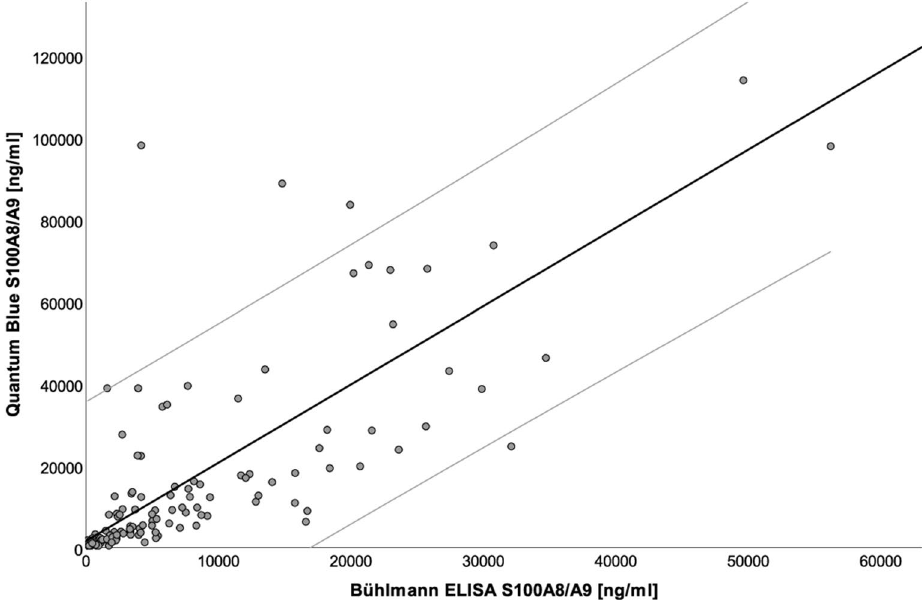
Figure 1. Calprotectin levels in saliva. Scatter plot showing the correlation between calprotectin levels in saliva determined by QUANTUM BLUE sCAL rapid test and the BÜHLMANN MRP8/14 ELISA with a Spearman correlation of r sp = 0.848 (black line, p < 0.001) and the 95% confidence interval (95% CI 0.245; 0.336, grey